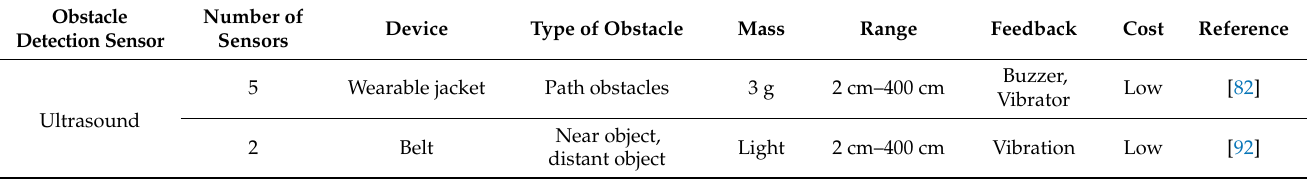
Table 4. Selected obstacle detection sensors, type of wearables, sensor specifications, and feedback for assistive